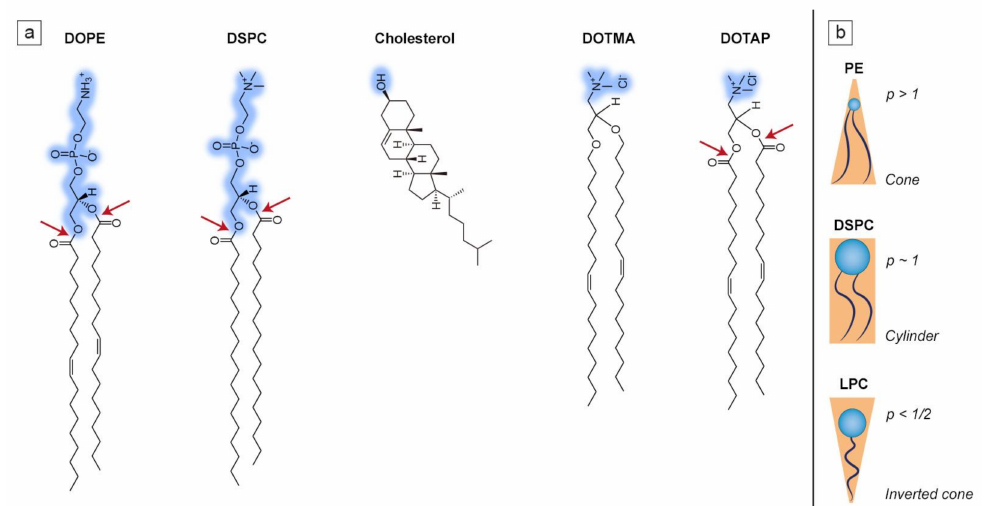
Figure 2. Examples of lipids commonly used in liposomal design. ( a ) Hydrophilic head groups are marked in blue while ester bonds are marked with the red arrows; ( b ) simplified representation of the influence of the packing parameter ( p = v / al, where v is the molecular volume, a is the cross-sectional area of the head group, and l is the length of the molecule) on the molecular shape of lipids such as phosphatidylethanolamine (PE), 1,2-distearoyl-sn-glycero-3-phosphocholine (DSPC)